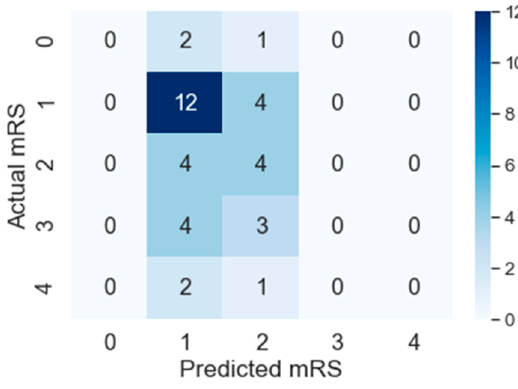
Figure 11. Confusion matrix of PMFE-SN without augmentation.